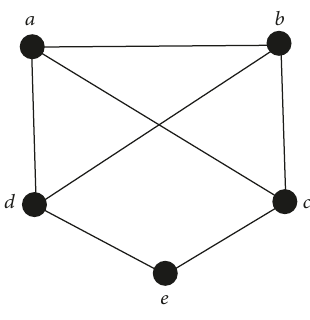
Figure 1: Undirected